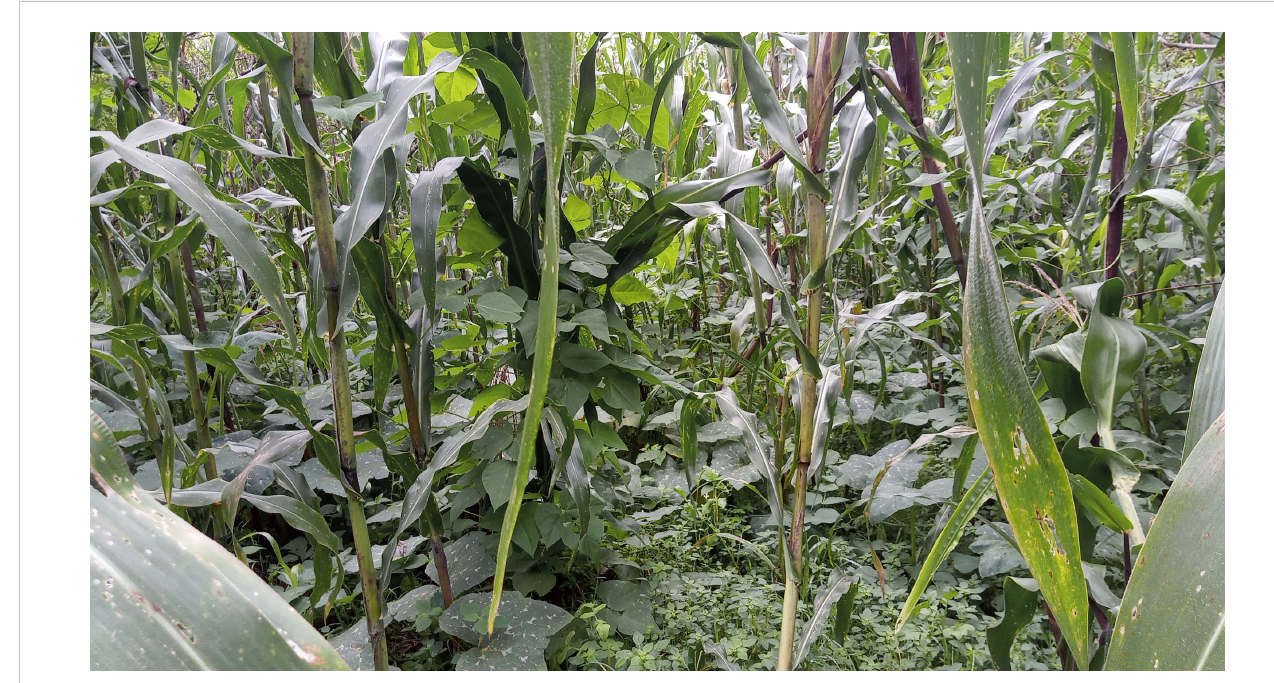
FIGURE 1 Inside a milpa fi eld of Nahuatl farmers in the Sierra Norte, Puebla,